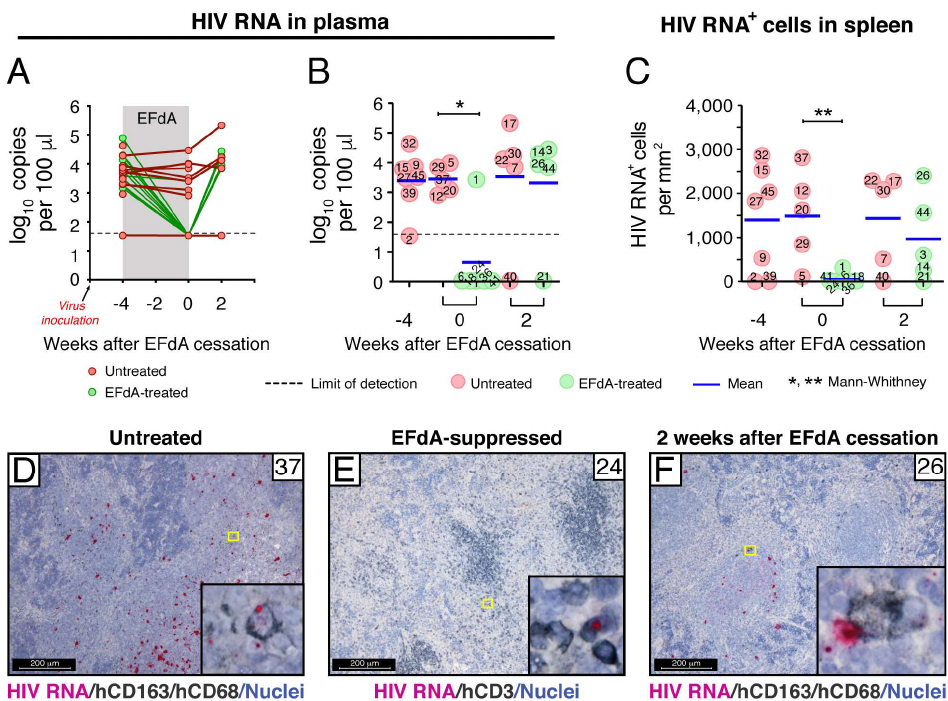
Figure 3. Effect of EFdA administration on the level of HIV RNA + cells in NSG-BLT mouse spleens. HIV RNA levels in NSG-BLT mouse plasma by the Abbott RealTime HIV-1 Viral Load (PCR) assay represented by a time-course in all individual mice ( A ) or by the actual value for each individual mouse per group ( B ). RNAscope ISH using an HIV-gag-pol antisense probe detected HIV RNA+ cells in NSG-BLT mouse spleens ( C ). Fifty images of representative white pulp regions containing human CD3 + and CD163 + cells were acquired at a magnification of 630x for each spleen. HIV RNA + cells were enumerated by ImageJ software. The results of 3 RNAscope assays with 3 tissue sections per spleen are represented as the mean value in panel ( C ). The Mann Whitney U-test performed a statistical comparison between groups and was considered significant at * P < 0.05 ( B ) and ** P < 0.01 ( C ). Phenotyping of HIV RNA + cells was accomplished by combined RNAscope in situ hybridization and chromogenic IHC for the human macrophage markers hCD163 and hCD68 ( D , F ) and human T-cell hCD3 ( E ). HIV RNA in the panel ( D) and ( E ) insets was visualized by alkaline phosphatase-Fast Red fluorescence detection. Nuclei were counterstained with hematoxylin. Yellow ( D – F ) rectangles outlined the region of interest and was magnified in the insets. Representative images of spleens from untreated mouse #37 ( D ), EFdA-suppressed mouse #24 ( E ), and mouse #26 2 weeks after EFdA cessation ( F ).